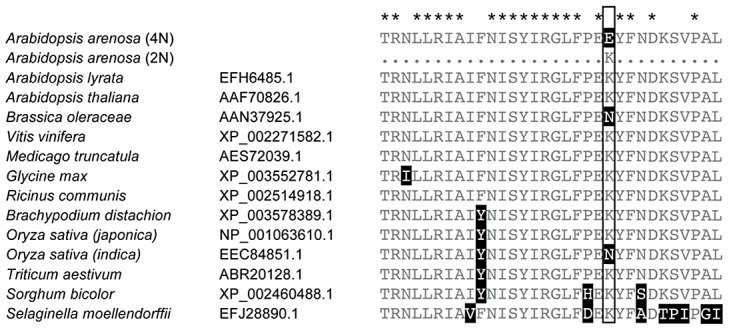
Conservation within the HORMA domain of ASY1.Alignment of a portion of the conserved HORMA domain of ASY1 with related sequences obtained from GenBank (Species names and GenBank numbers are given). Stars above the alignment indicate amino acids perfectly conserved among these sequences. The boxed amino acid position indicates one in which a derived allele (K>E) predominates in tetraploid A. arenosa that is rare in diploid A. arenosa and not found in other species reported in Genbank.